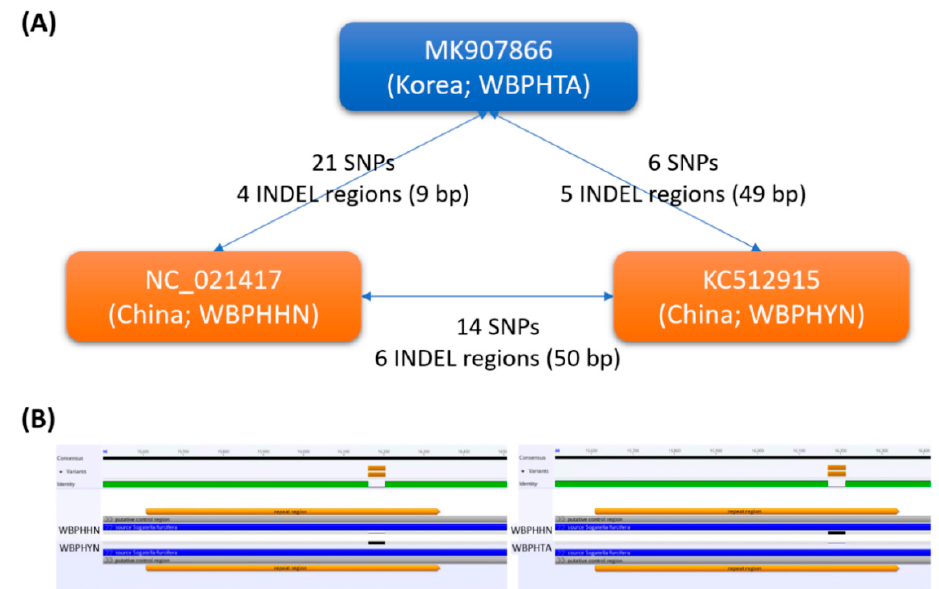
Figure 5. Intraspecific variations were identified from the three WBPH mitogenomes. ( A ) The blue-colored round box indicates WBPHTA mitogenome and two yellow-colored round boxes mean the two previously sequenced WBPH mitogenomes. Numbers of SNPs and INDELs with the total length of INDELs identified from the two WBPH mitogenomes are presented on the lines connected to the boxes. ( B ) Diagram of the longest INDEL identified among three WBPH mitogenomes.